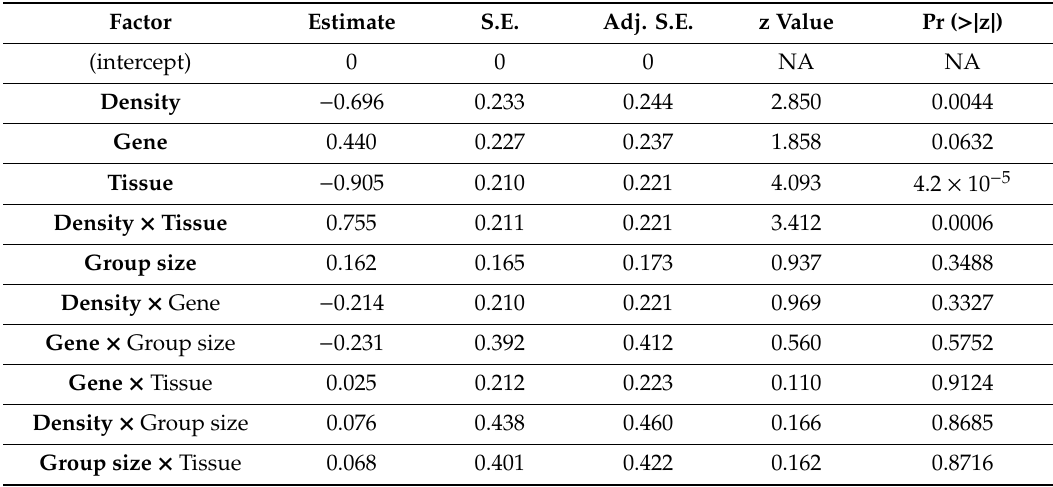
Table 1. Results of model averaging. The factors included in the best model after model selection are shown in bold